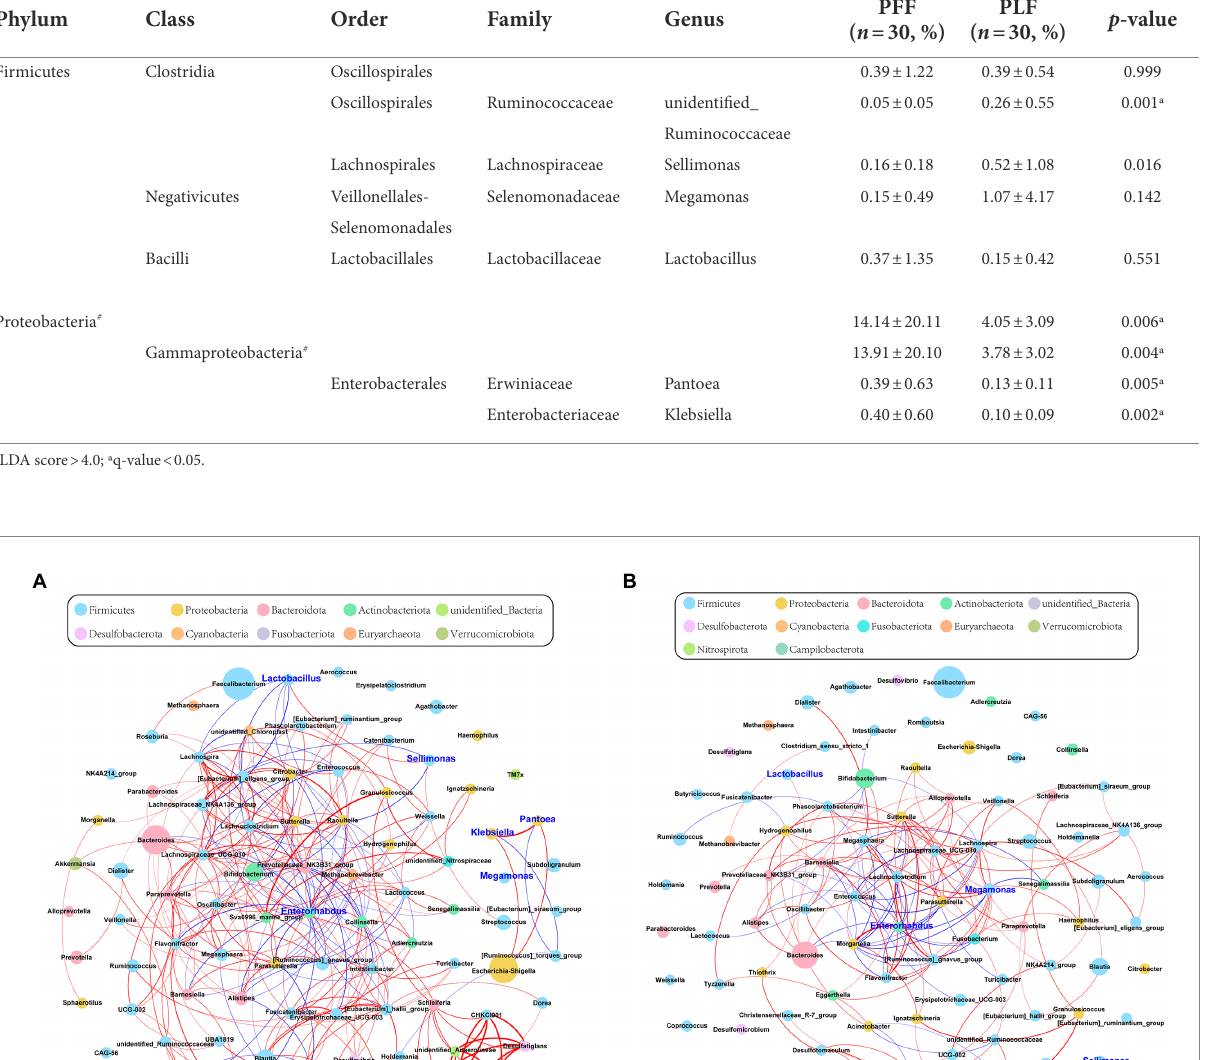
TABLE 1 The differential microbiota at different levels of biological classification with LEfSe analysis and MetaStat analysis. Phylum